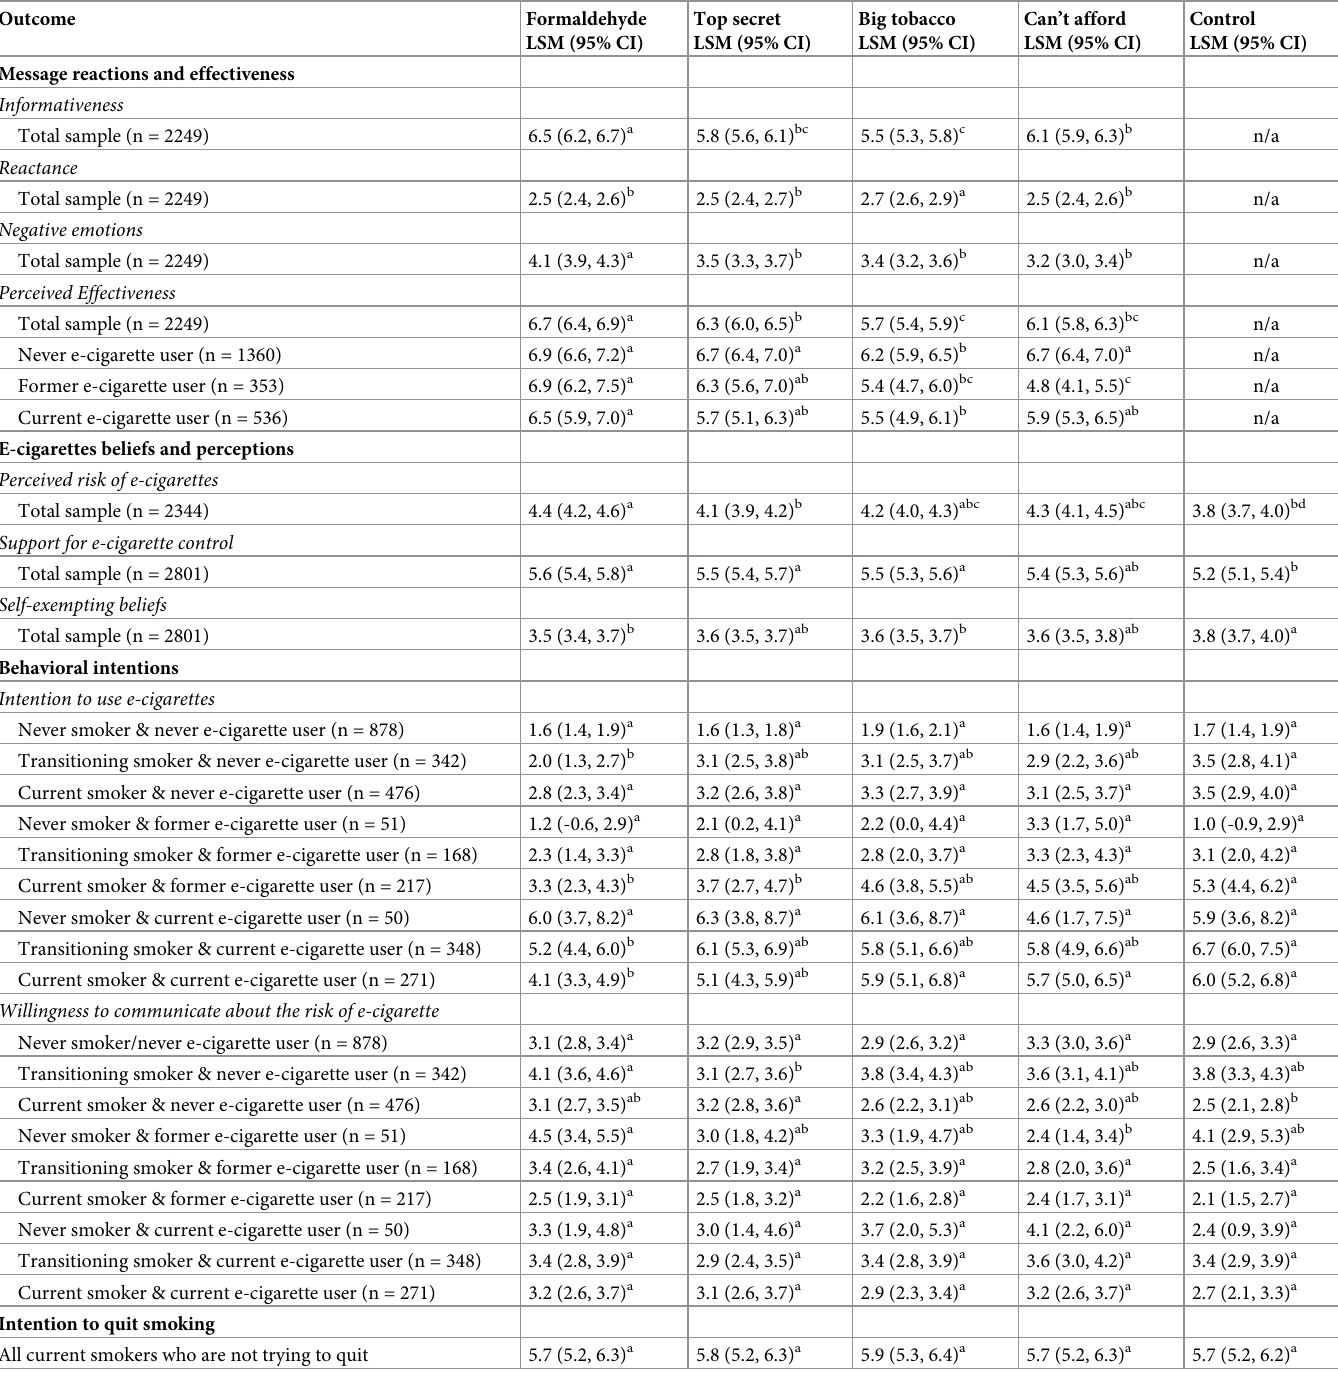
Table 3. Impact of condition on dependent variables in the total sample and by smoking and e-cigarette use